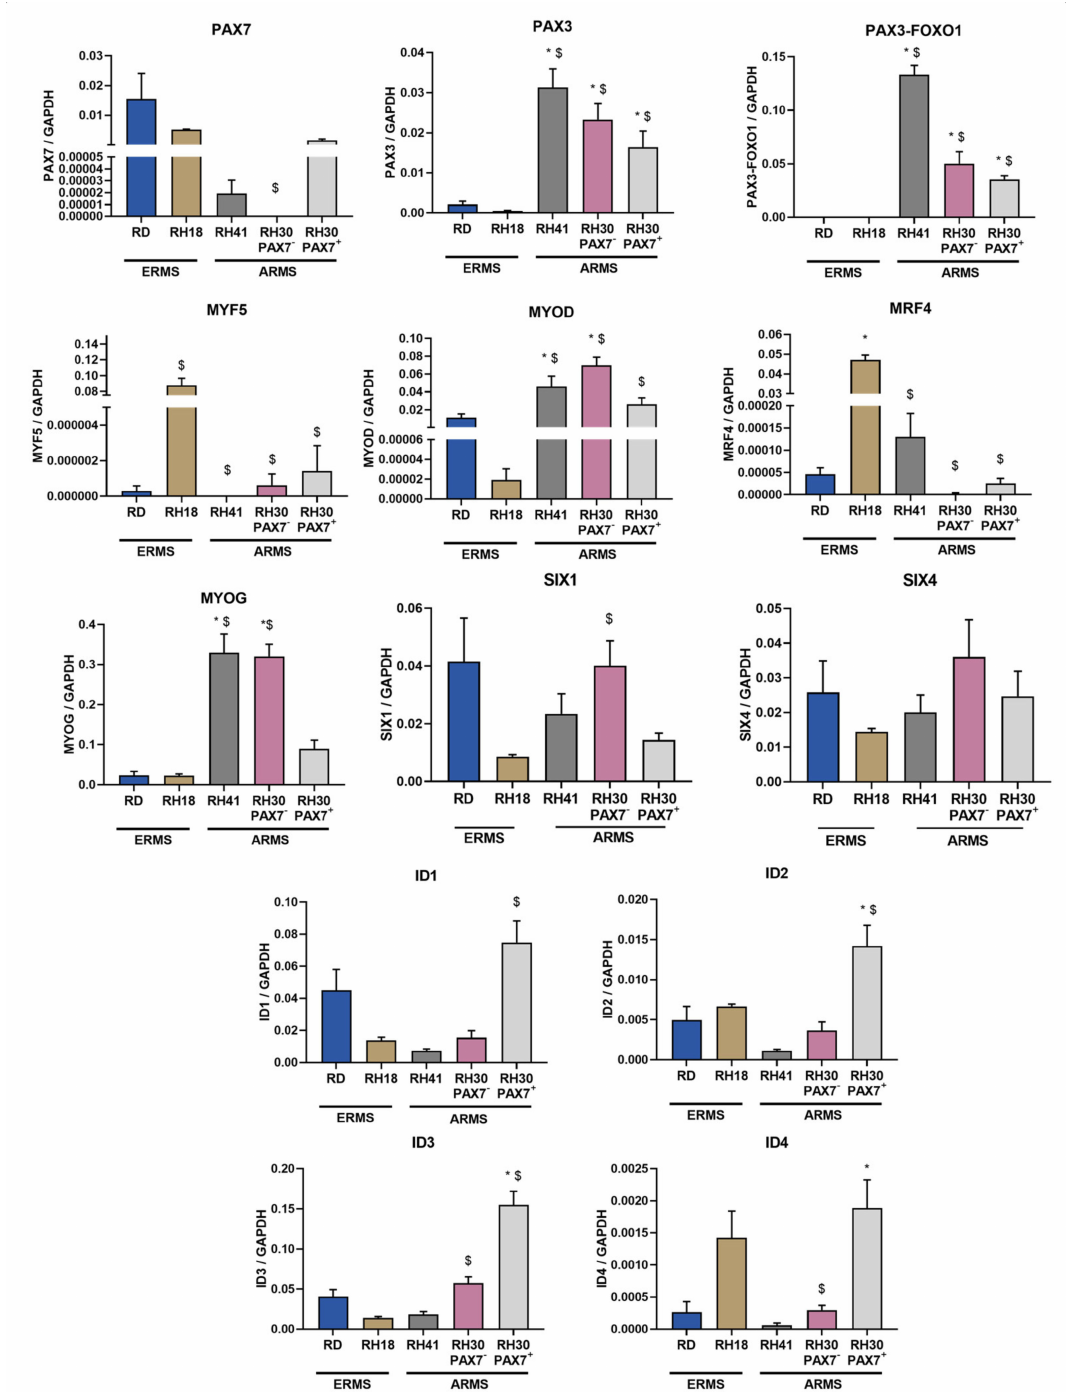
Figure 7. Transcription factors regulating myogenic differentiation were differentially expressed in ERMS and ARMS cells. mRNA expression levels were evaluated with qPCR. Data were calculated with 2 − ∆ Ct method using GAPDH as a constitutive gene. The data on graphs show means ± SEM, n = 3–4. Statistical analysis was performed with ANNOVA with Tukey posttest to analyze differences between ERMS and ARMS cell lines. Two types of differences were shown. * symbol indicates statistically significant differences compared to RD ERMS cell lines ( p < 0.05), whereas $ symbol designates statistically significant differences compared to RH18 ERMS cell line ( p <